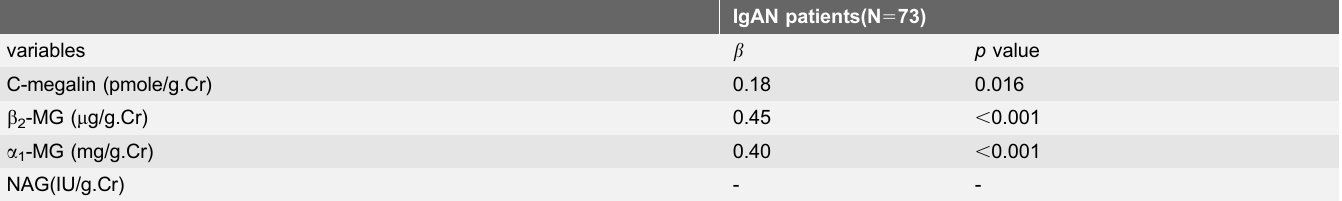
Table 2. Stepwise multiple regression analysis of levels of urinary total protein excretion with relevant factors.